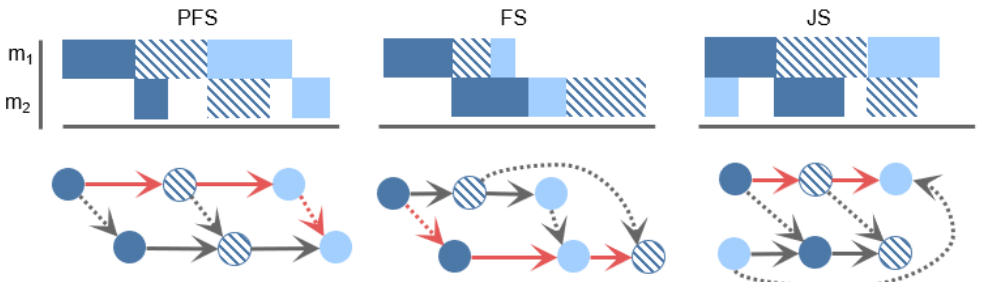
Figure 1. Exemplary feasible solutions to (flexible) PFS , FS and JS problems with three jobs and two machines (Gantt and DASG